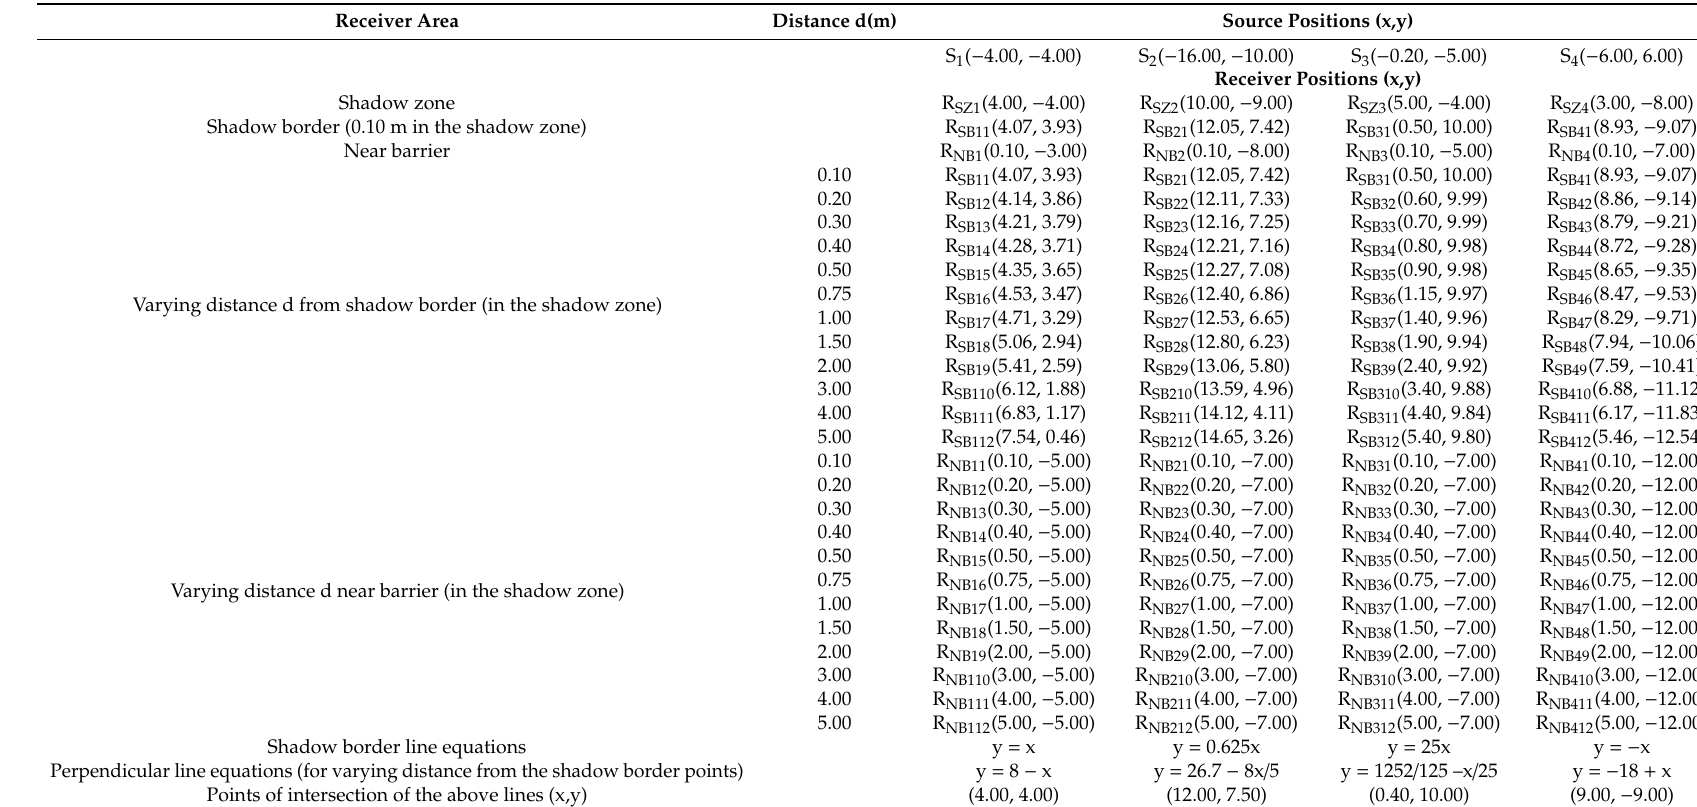
Table A1. Source and receiver positions for calculation of insertion loss via FEM and common formulae (correspond to positions shown in Figure